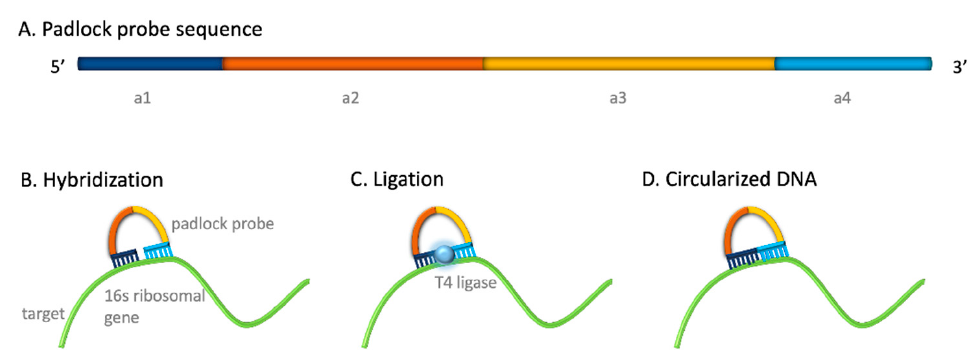
Figure 1. ( A ) Design of the specific padlock probe for the detection of E. coli comprising two complementary sequences to the target (a1 and a4) and two sequences (a2 and a3) to achieve the readout. ( B ) Hybridization of the padlock probe to the 16S ribosomal E. coli gene. ( C ) Ligation by the T4 DNA ligase enzyme. ( D ) Circularized DNA templates obtained after ligation of the padlock probes and used for the rolling circle amplification.